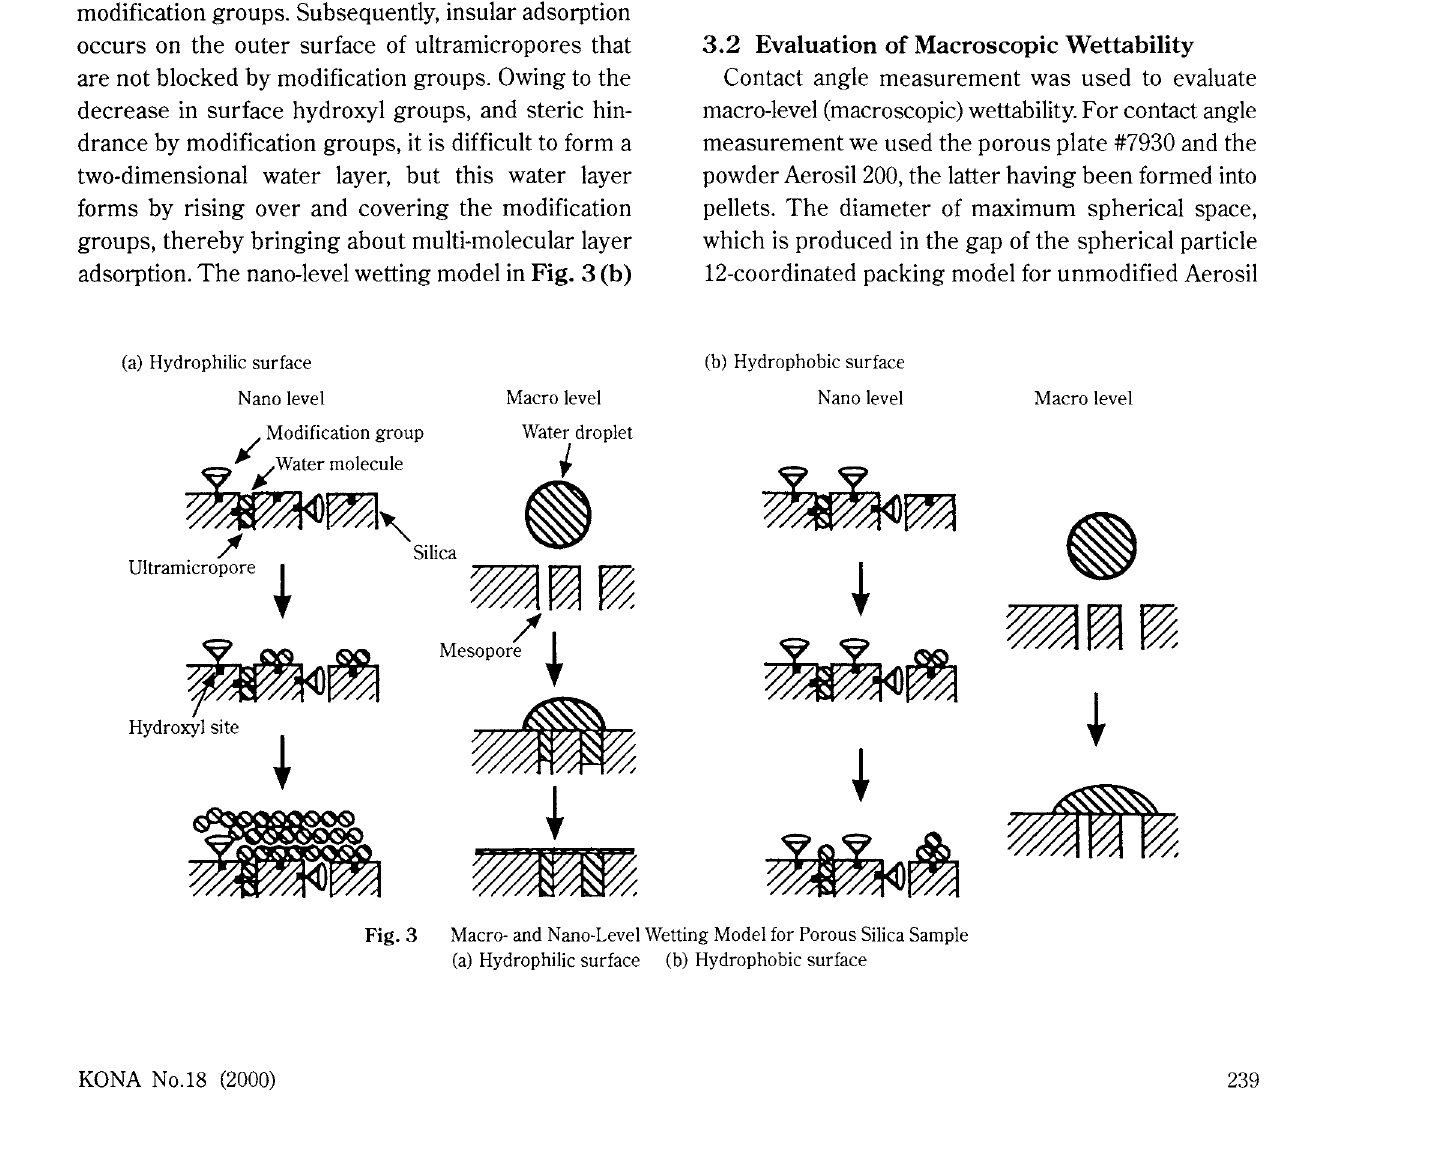
Fig. 3 Macro· and Nano-Level Wetting Model for Porous Silica Sample (a) Hydrophilic surface (b) Hydrophobic